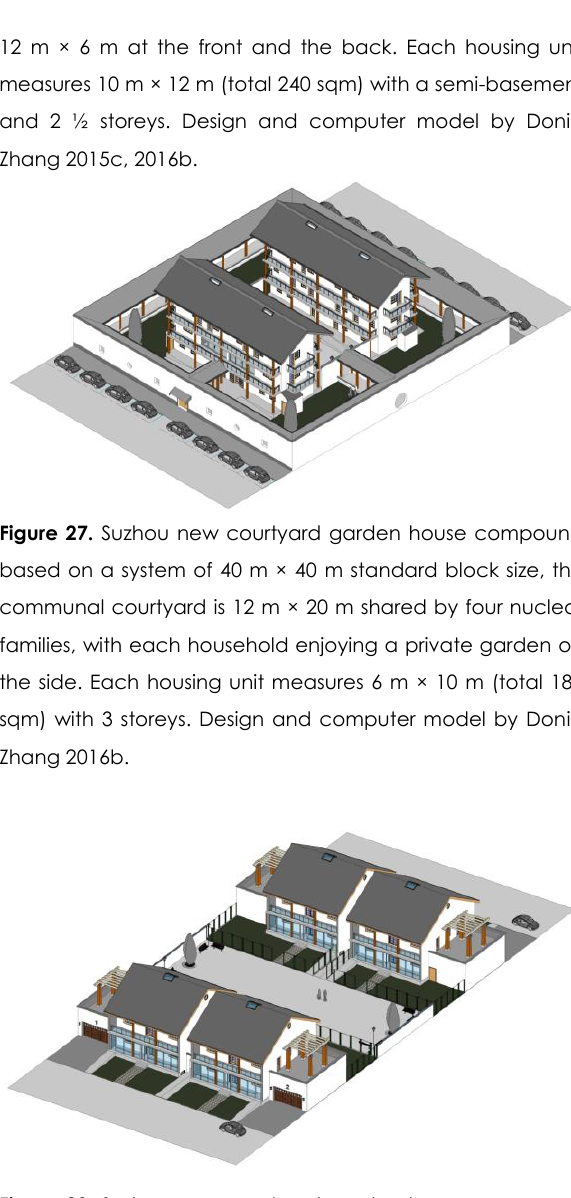
Figure 28. Suzhou new courtyard garden house compound based on a system of 40 m × 66 m standard block size, the communal courtyard is 14 m × 40 m shared by four nuclear families, with each household enjoying a private garden of 12 m × 6 m at the front and the back. Each housing unit measures 10 m × 12 m (total 240 sqm) with a semi-basement and 2 ½ storeys. Design and computer model by Donia Zhang 2015c,